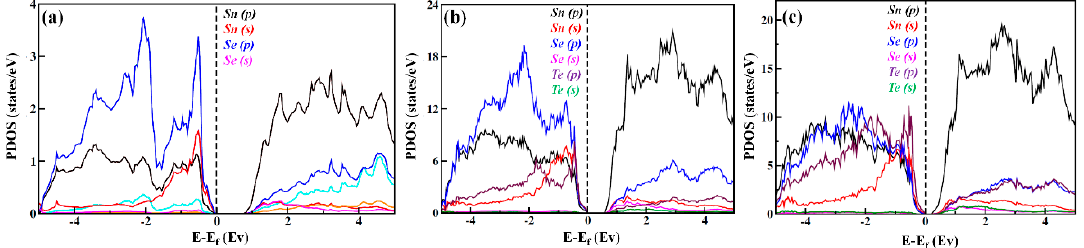
Figure Figure 7. The projected density of states per atom of ( a ) SnSe, ( b ) SnSe 0.725 Te 0.125 , and ( c ) SnSe 0.75 Te 0.25 , respectively.